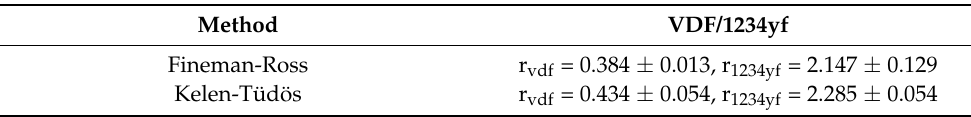
Table 3. Reactivity ratios of VDF and 1234yf determined at 60 ◦ C in DMC using initiated by P16 in the presence of Co(acac) 2